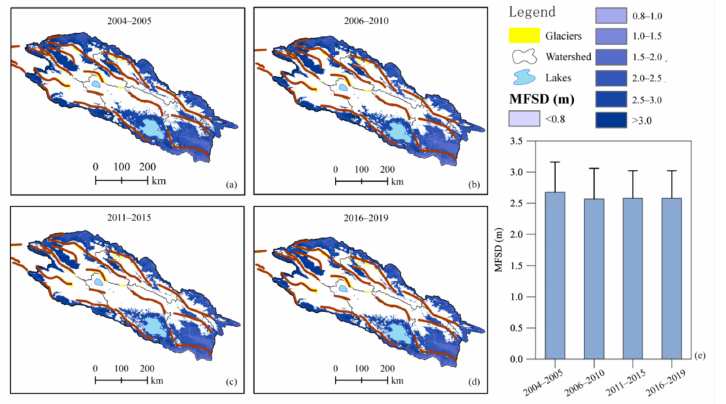
Figure 9. Spatiotemporal variations of maximum frozen soil depth (MFSD, m) in the Qilian Moun- tains from 2004 to